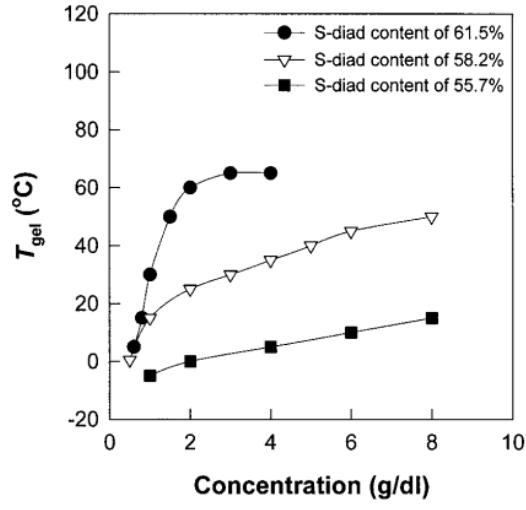
Figure 5. Gelation temperature of HMW s-PVA/DMSO/water solution measured by test tube tilting method. Reproduced with permission from Choi et al. Macromolecules 2001 , 34 , 2964 [165]. Copyright 2001 American Chemical